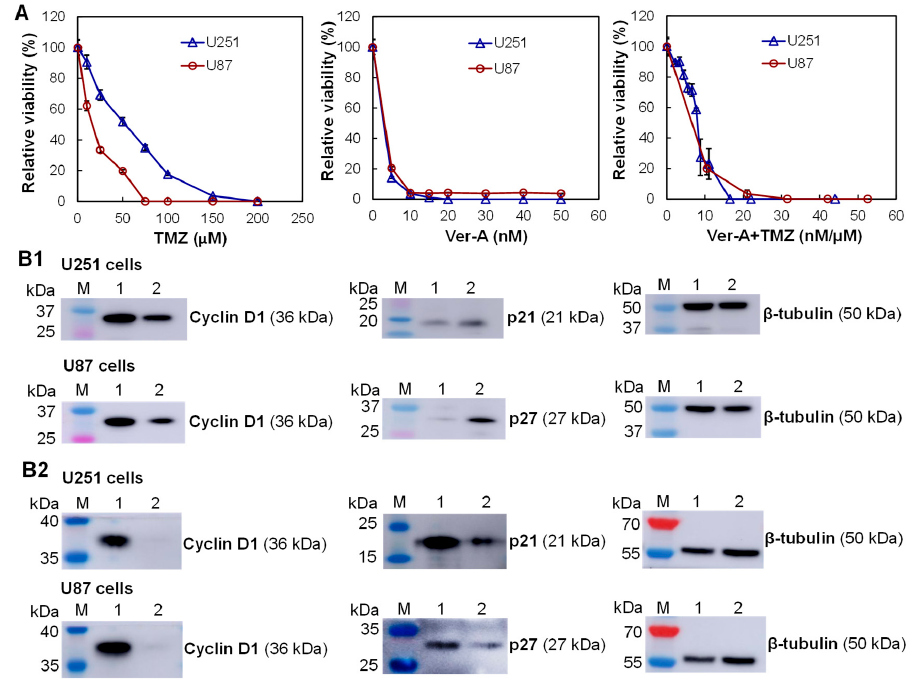
Figure 4. In vitro anti-GBM cytotoxicity of free drugs. ( A ) Evaluation of TMZ, Ver-A, and combined TMZ and Ver-A using U87 and U251 cells. ∆ : U251 and ○ : U87. Data represent mean ± SEM, n = 3. ( B ) Western blotting analysis of proliferation and apoptosis biomarkers in U87 cells and U251 cells treated with ( B1 ) Ver-A or ( B2 ) TMZ in combination with Ver-A. M: marker; 1: GBM cells without treatment; 2: GBM cells treated with 2 nM Ver-A or 20 µ M TMZ and 2 nM Ver-A.